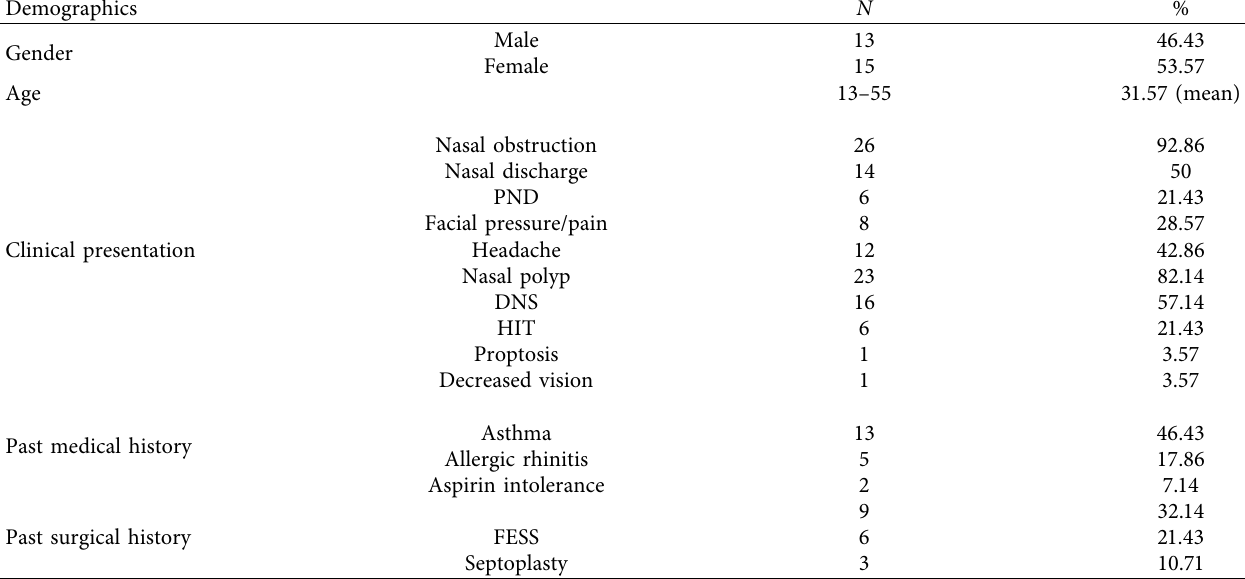
Table 1: Characteristics of patients included in the